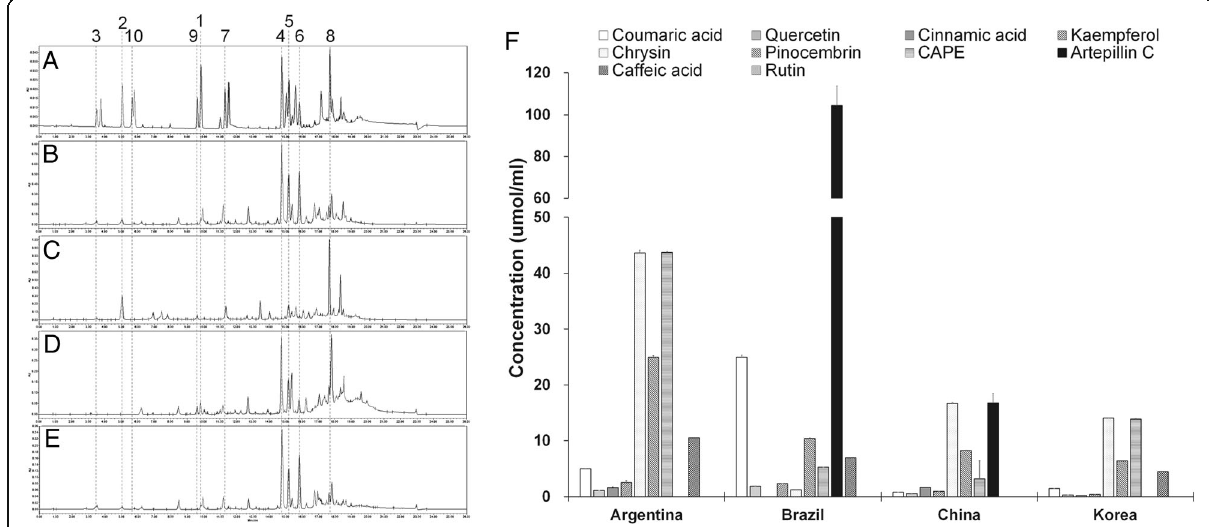
Fig. 2 UPLC chromatograms of EEP samples from South America ( b Argentina, c Brazil) and Asia ( d China, e Korea). a The chromatogram obtained from polyphenol standards. The numbers and the corresponding dotted lines indicate each phenolic standard. 1 = cinnamic acid; 2 = coumaric acid; 3 = caffeic acid; 4 = chrysin; 5 = pinocembrin; 6 = CAPE; 7 = kaempferol; 8 = artepillin C; 9 = quercetin; 10 = rutin. f Bar graph showing the concentrations of ten phenolic compounds in various EEP samples of different